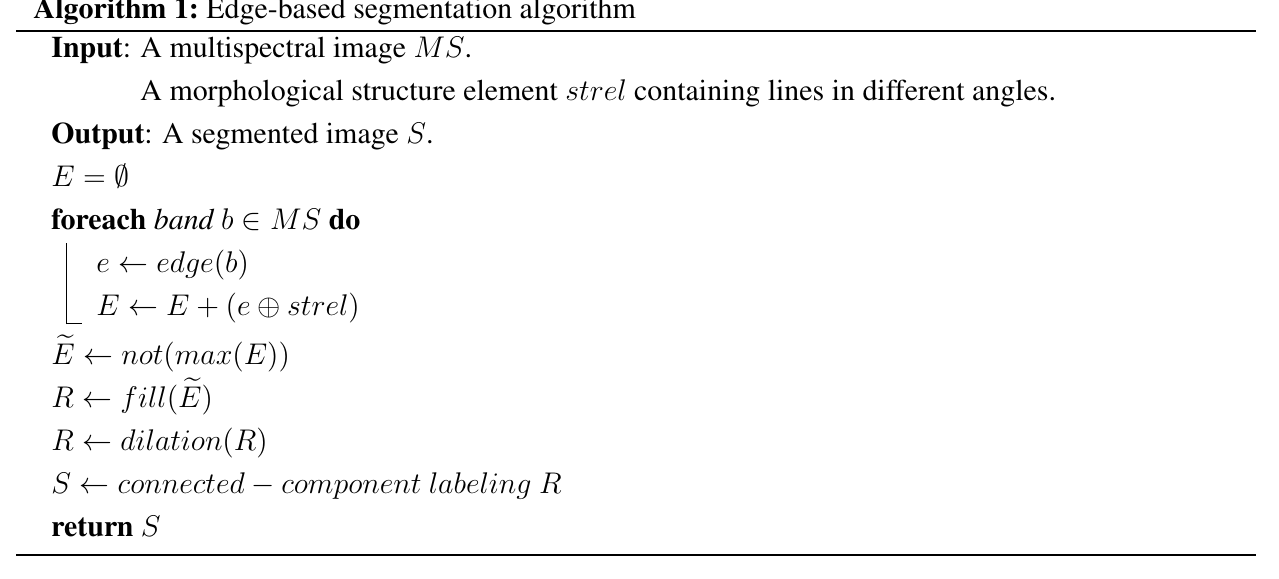
Algorithm 1: Edge-based segmentation